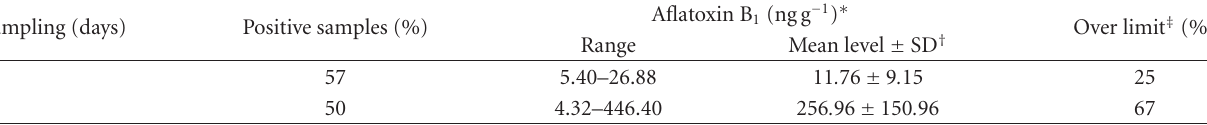
Number of producer strains versus total strains. † Minor and major levels of AFB